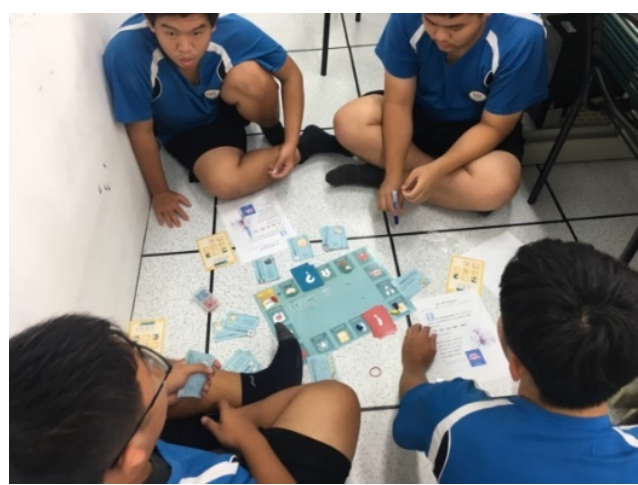
Figure 5. Control group playing scene.